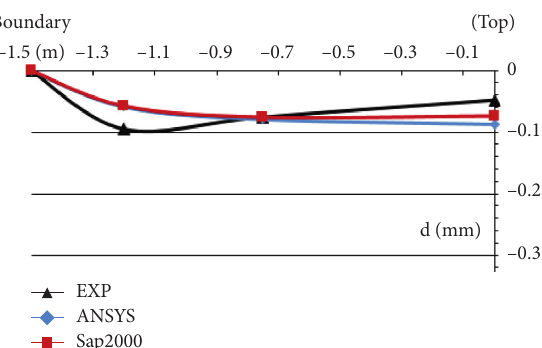
Figure 10: Load and vertical displacement in methods.